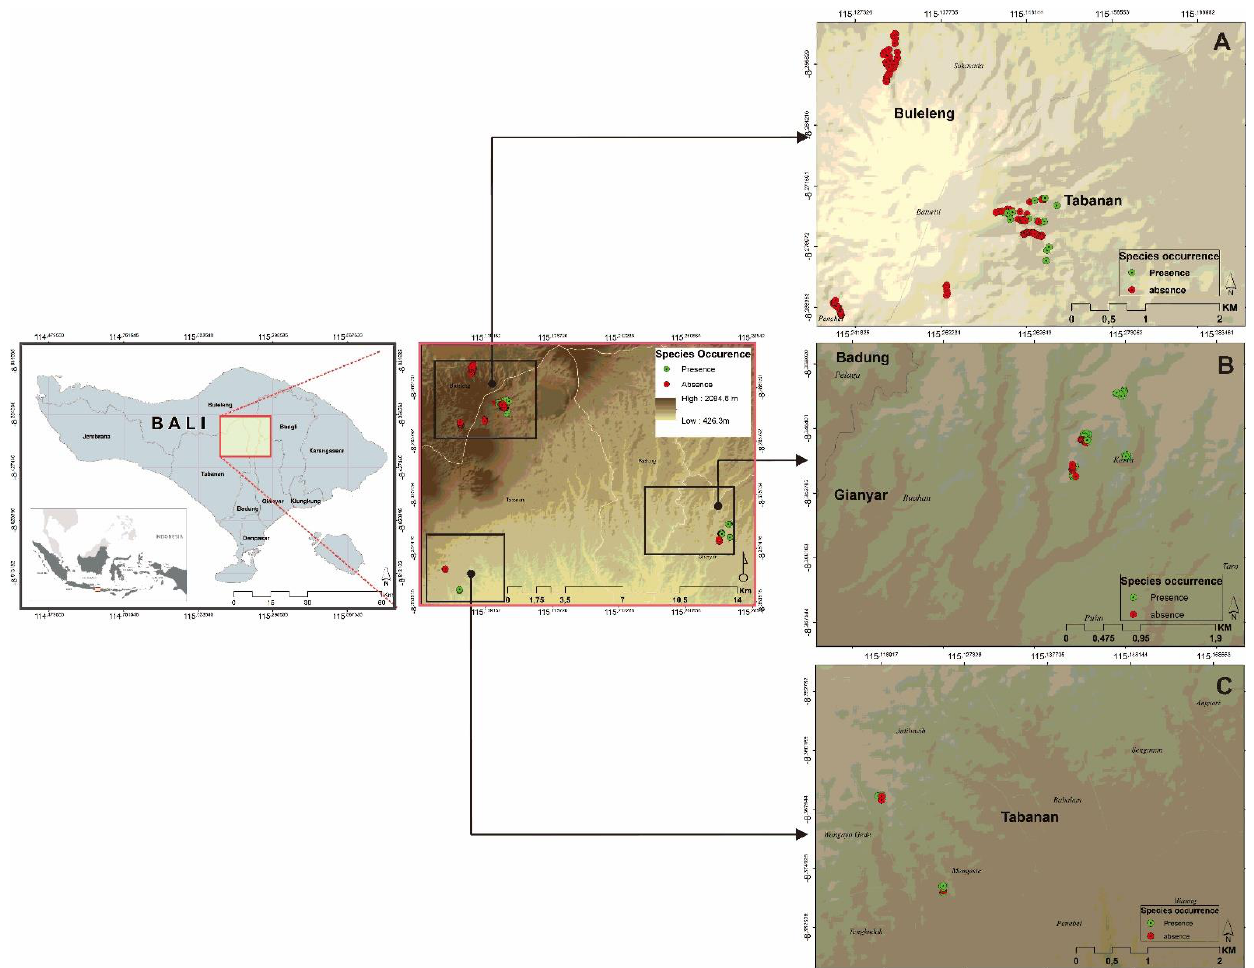
Figure 1. Research locations: ( A ). Bukit Tapak nature reserve, ( B ). Pilan customary forest, and ( C ). Jatiluwih. Green dot represent the presence of this species and red dot represent the absence of this species in those locations.